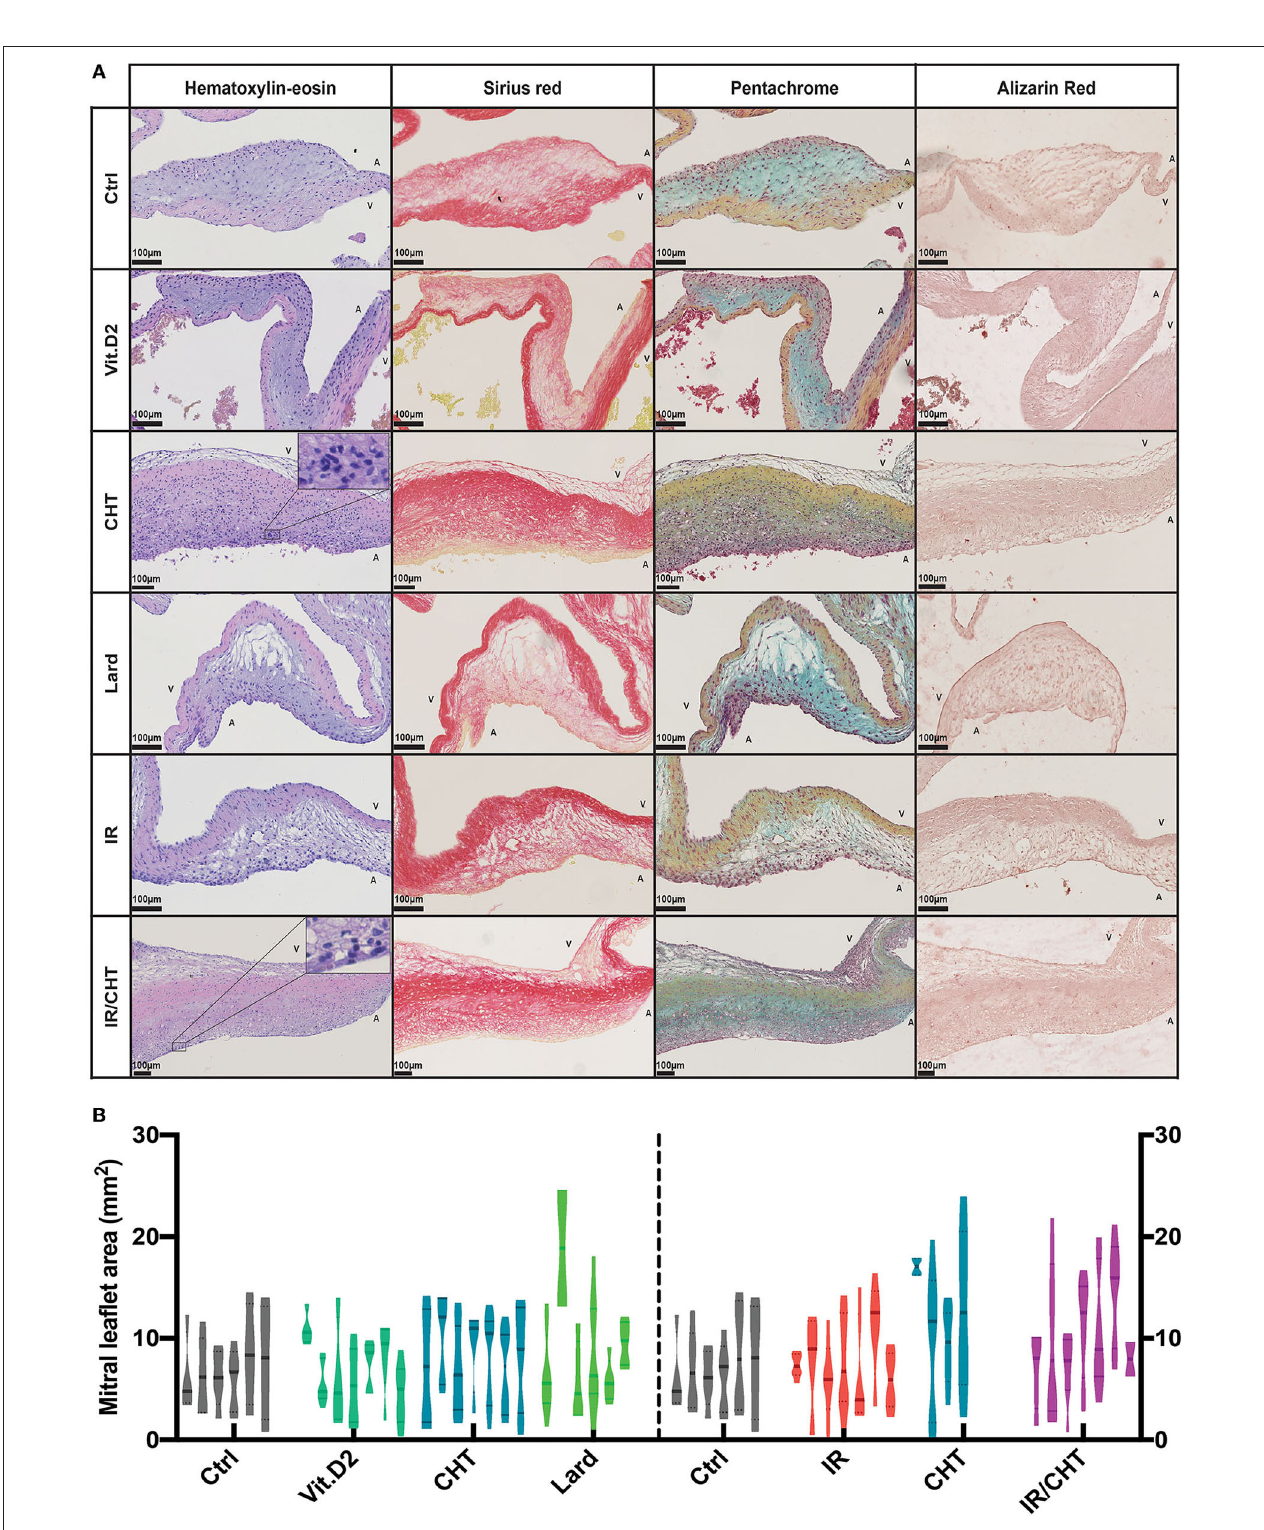
FIGURE 3 | Effect of cholesterol-enriched diets on the mitral valve leaflet histology. (A) Representative pictures of mitral valve leaflet sections stained with hematoxylin-eosin, sirius red, and Movat’s pentachrome per rabbit group as indicated. Magnified areas depict neutrophil infiltrates in valvular atrialis. Scale bars = 100 µ m. (B) Violin plots represent mitral valve leaflet area measured on the histological mitral valve sections (each violin box represents one rabbit, 4–8 slides per rabbit) stained with hematoxylin-eosin. Four-group comparisons were performed by using a nested-GLM model and post-hoc SIDAK test on log-transformed data. P = non-significant. A, indicates atrial side; V, indicates ventricular side.